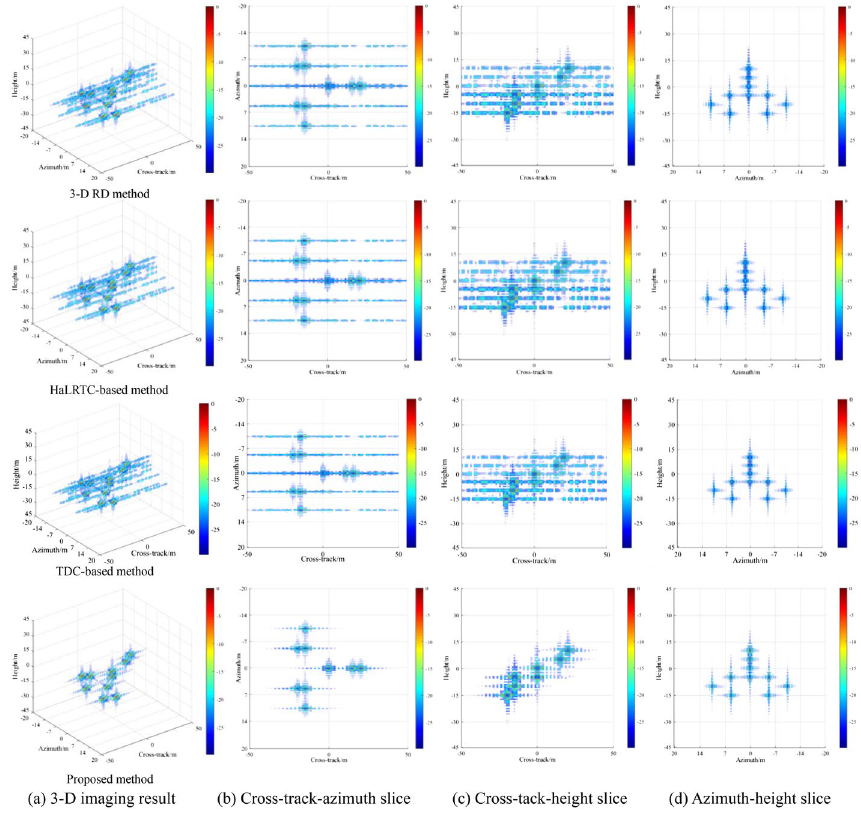
Fig. 6 3D imaging results of various methods with 80% sparse data. The SNR is set as 10 dB. The limited amplitude is 25 −